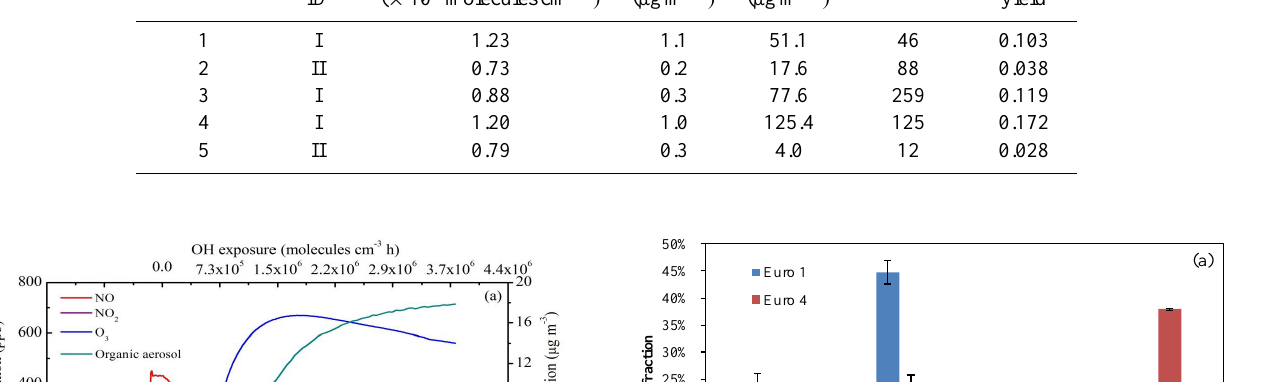
Table 3. Summary of the results for the light-duty gasoline vehicle photo-oxidation experiments. Experiment